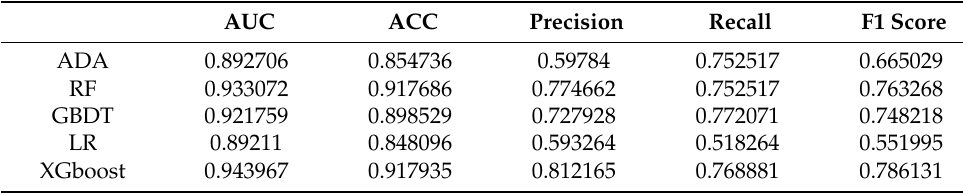
Table 2. Evaluation metrics of five ML